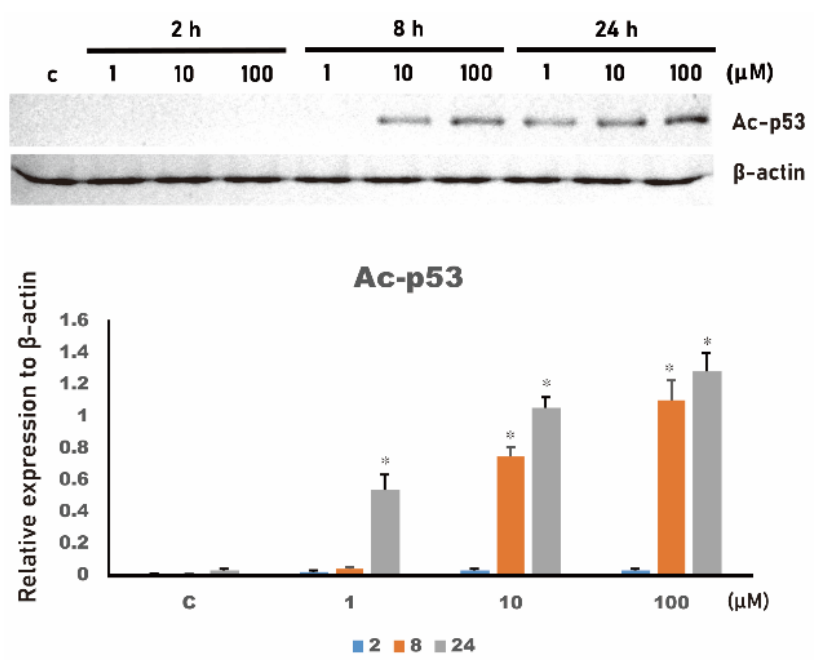
Figure 2. The change in Ac-p53 expression levels upon 4HR treatment in YD-15 cells. When compared to the untreated control, 4HR treatment increased Ac-p53 expression levels significantly (* p < 0.05 by Bonferroni test).